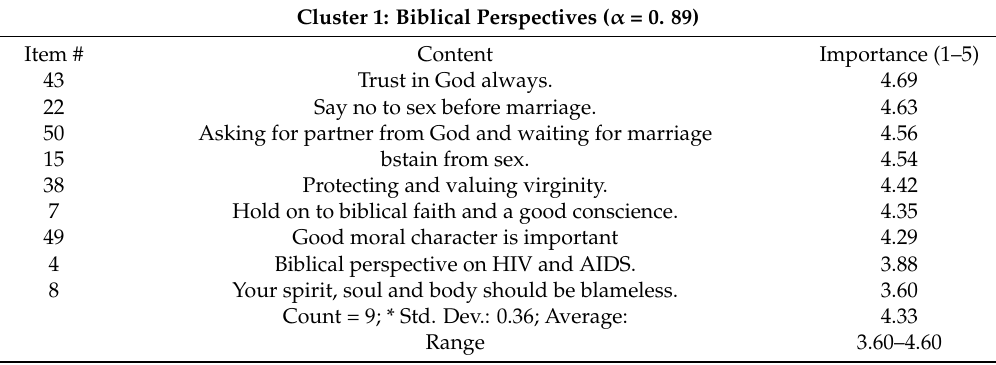
Table 2. Statements By Cluster (with Importance Summary Statistics) for Influences on Sexual Decision Making with Religion and First Sex ( N =